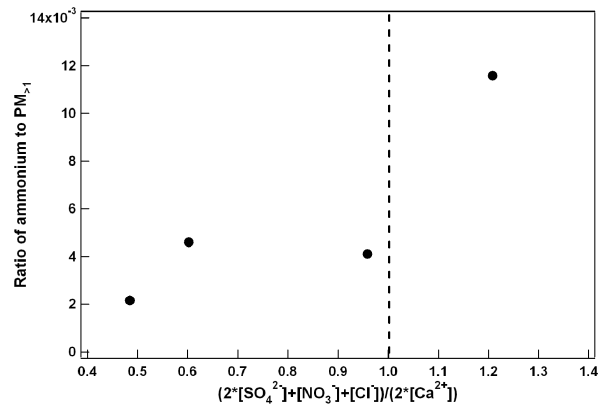
6. Scatter plots of ratios of NH + (2 × [SO 2 − ]+[NO − ]+[Cl − ])/(2 × [Ca 2 + ]) in PM > 1 during the 4 3 dust event on 24–26 April at Mt.